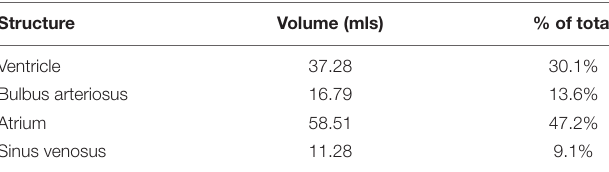
TABLE 2 | Cardiac structure volumes in milliliters (ml) and as percent of whole heart volume. Structure Volume